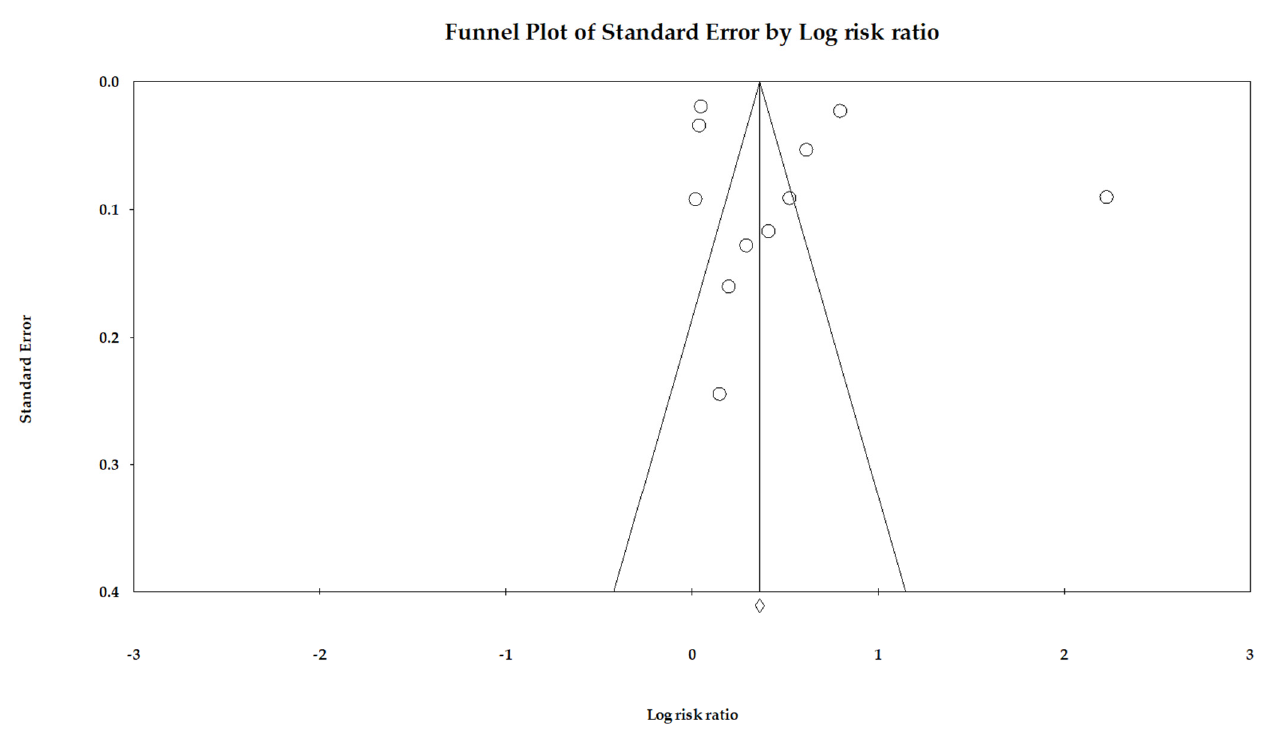
Figure 2. Funnel plot.